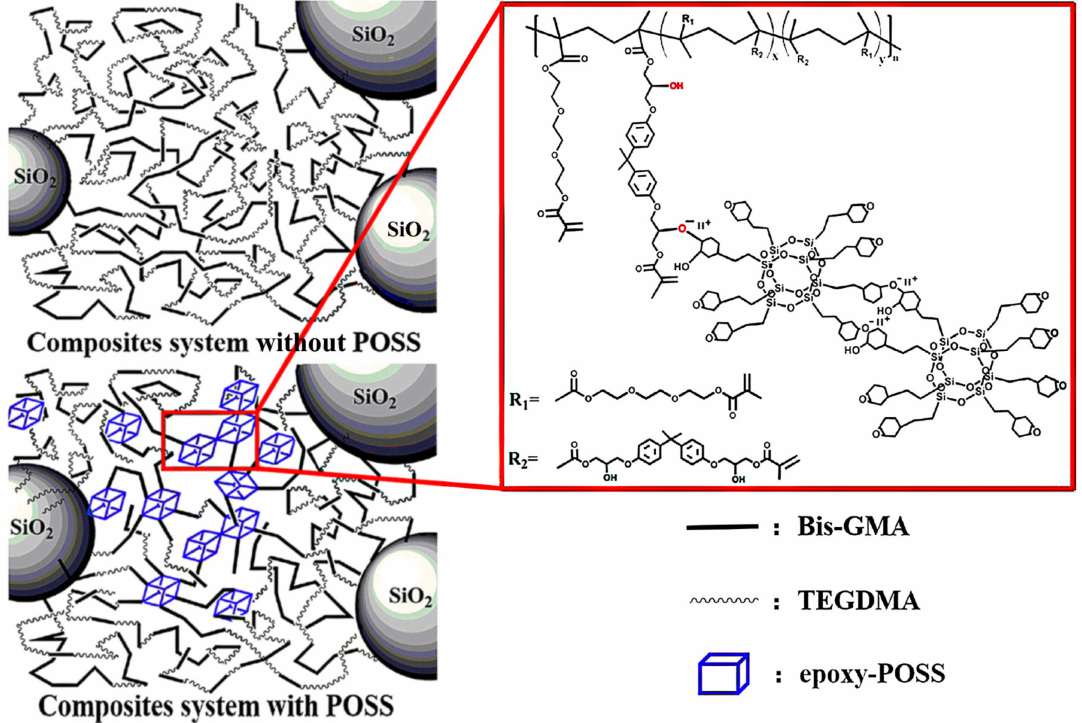
Figure 4. Schematic representation of dental composites system. Reprinted with permission from Li, Z.; Zhang, H.; Xiong, G.; Zhang, J.; Guo, R.; Li, L.; Zhou, H.; Chen, G.; Zhou, Z.; Li, Q. J. Mech. Behav. Biomed. Mater. 2020 , 103 , 103515 [34]